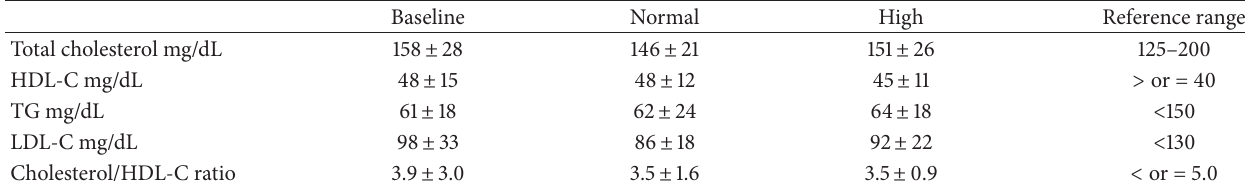
Table 3: Blood lipids.